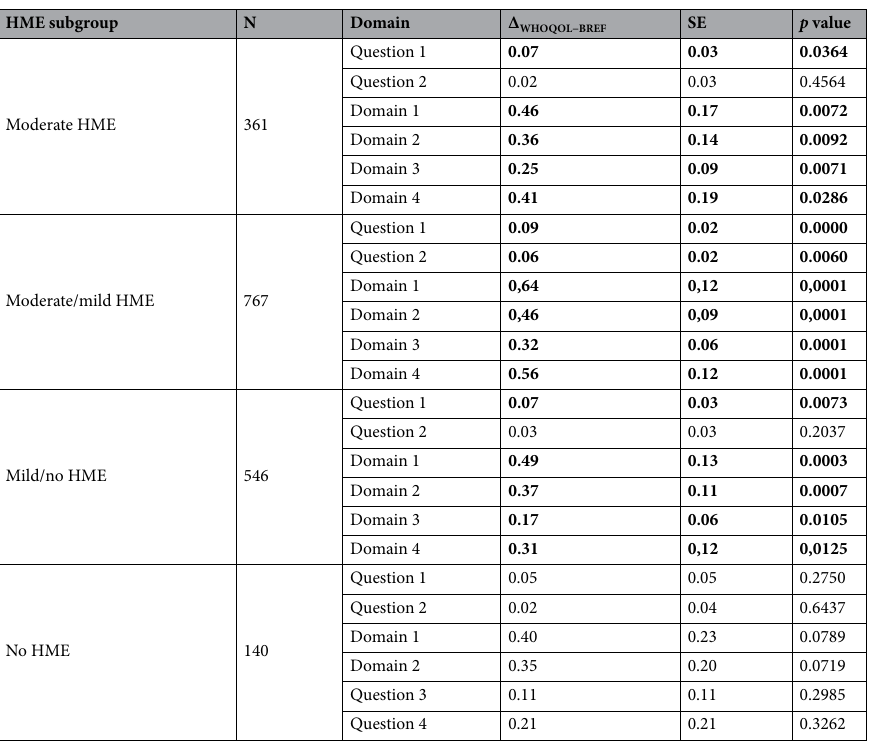
Table 6. Linear regression results of Δ WHOQOL−BREF as function of ΔMg 0.1 Moderate HME, serum Mg ≥ 0.5 mmol/L and < 0.66 mmol/L; Moderate/Mild HME, serum Mg ≥ 0.5 mmol/L and < 0.8 mmol/L; Mild/ No HME, serum Mg ≥ 0.66 mmol/L and < 0.8 mmol/L; No HME, serum Mg ≥ 0.8 mmol/L; severe HME cases (Mg < 0.5 mmol/L) were not included in the analysis due to limited sample size. HME, hypomagnesemia; Mg, magnesium; Δ WHOQOL−BREF , difference in World Health Organization quality of life questionnaire scores; ΔMg 0.1 , difference in the total serum Mg level between Visit 1 and Visit 2 normalized by 0.1 mmol/L; p values reflect whether Δ WHOQOL−BREF domains/questions are significantly and linearly related to the change in serum Mg level; significant p values (<0.05) are presented in